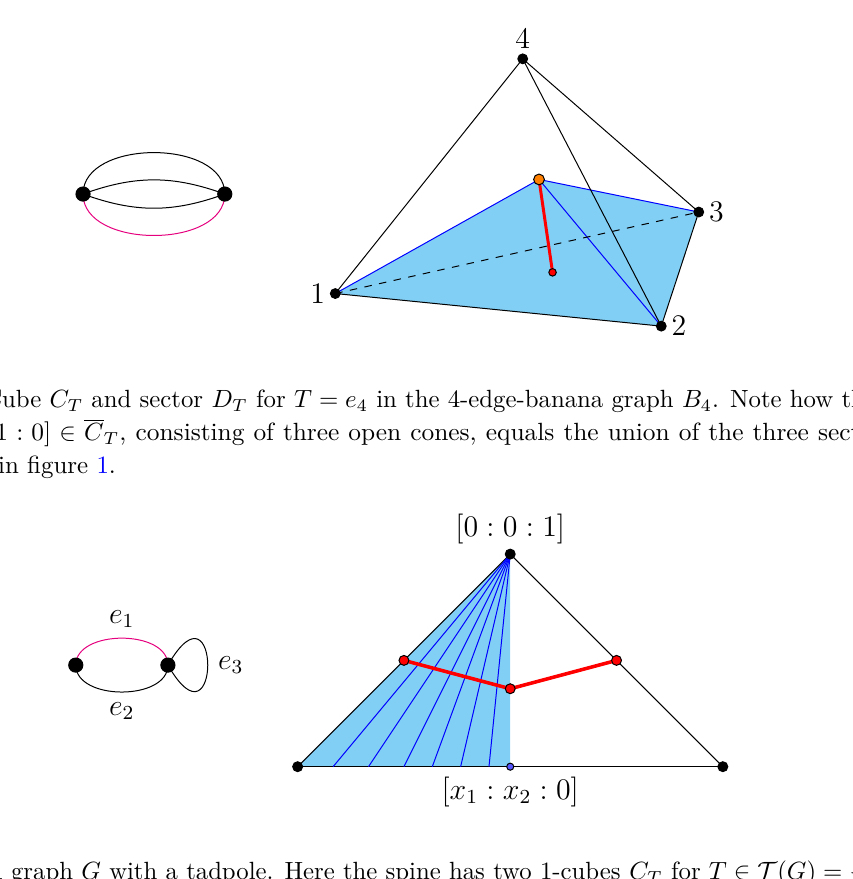
Figure 6 . A graph G with a tadpole. Here the spine has two 1-cubes C T for T ∈ T ( G ) = { e 1 , e 2 } . The blue lines indicate the fibers over the cube C , connecting its points to the faces at infinity, the e 1 point { x = x = 0 } and the line { x = 0 } 1 2 3